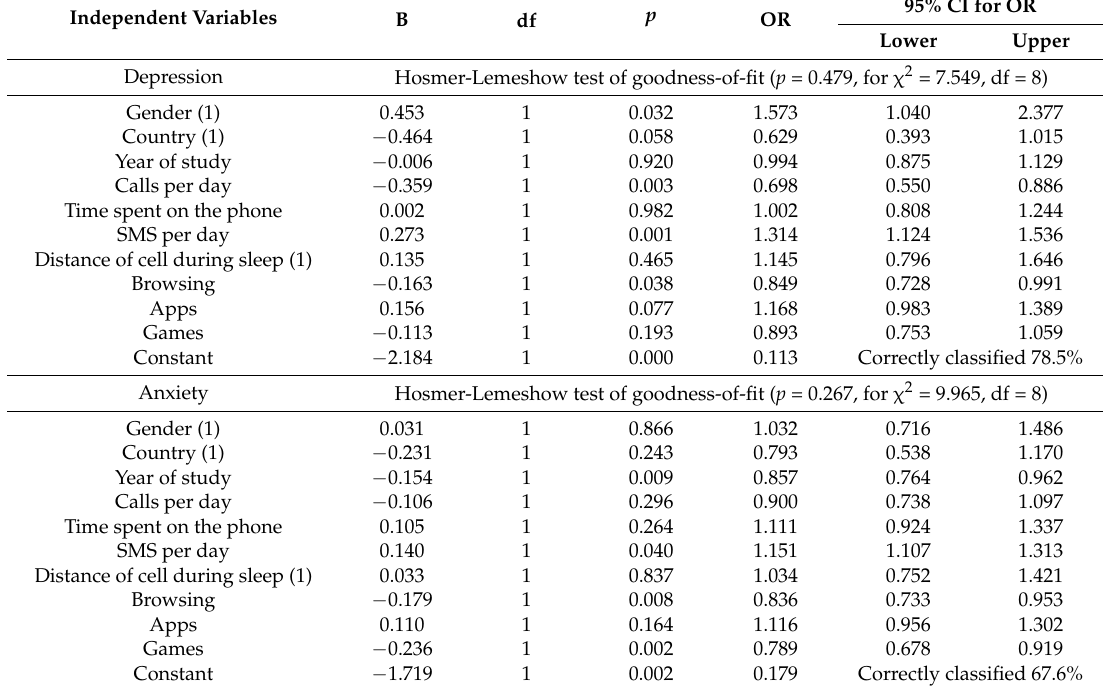
Table 5. Prediction of the levels of depression, anxiety, and stress in the surveyed students. Independent